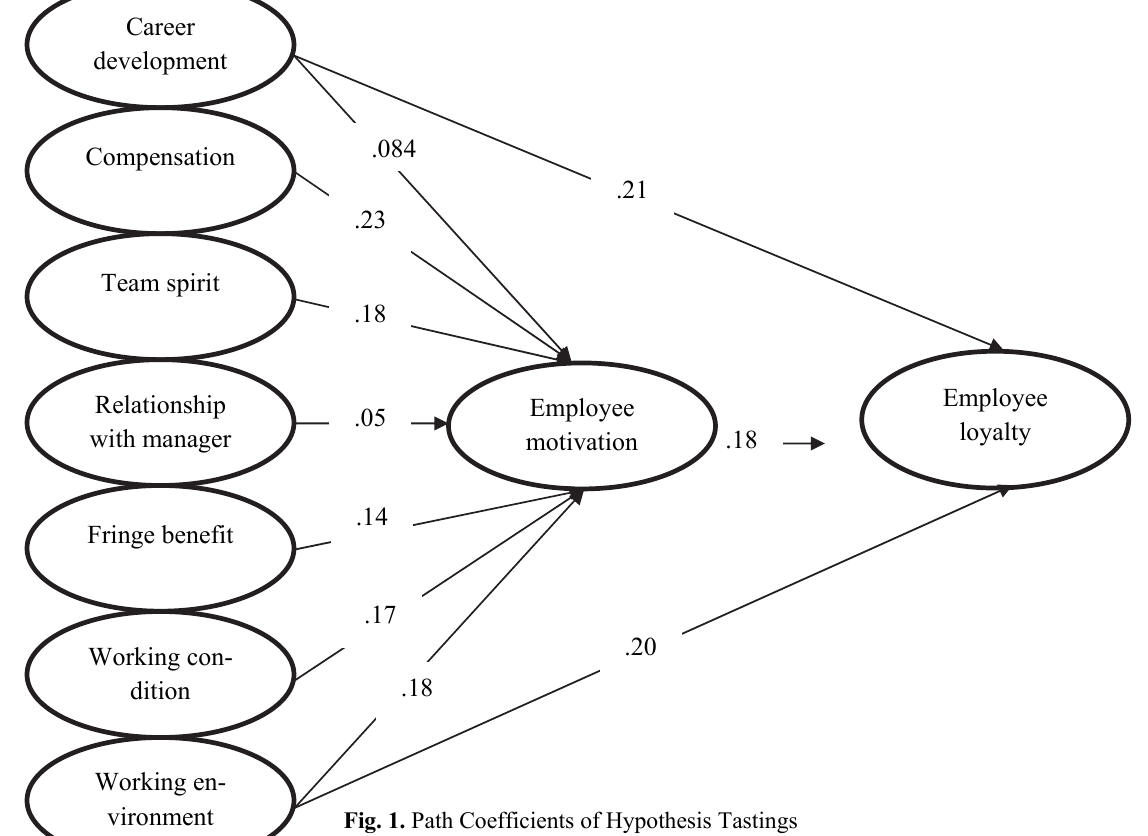
Fig. 1. Path Coefficients of Hypothesis Tastings